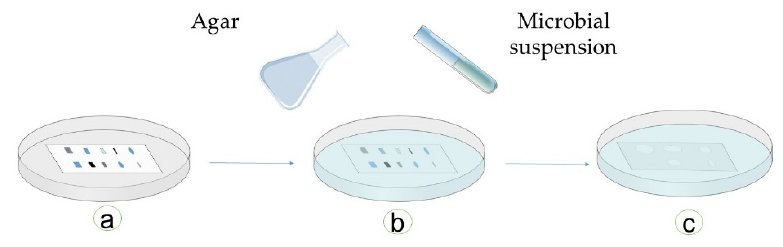
Figure 11. Schematic presentation of the immersion bioautographic method: ( a ) a developed chromatographic plate is placed in a dish; ( b ) agar is poured into this dish, and later, microbes are inoculated; ( c ) after an incubation time, the zones of inhibition can be seen on agar around the active antimicrobial compounds (adapted from [28,127,128,132]).